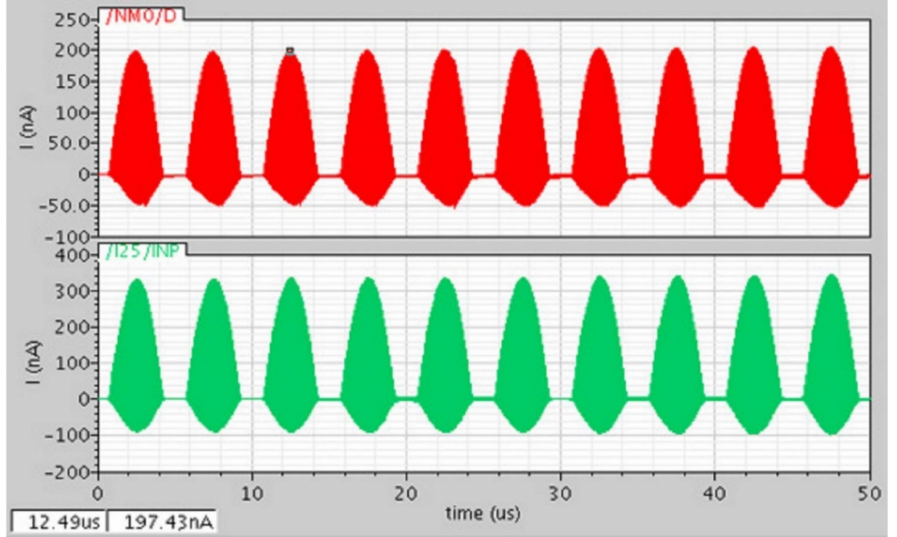
Figure 15. Electric